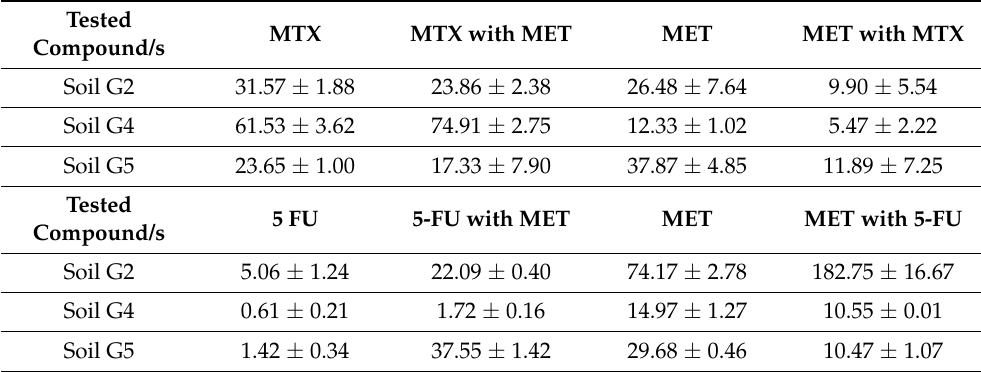
Table 3. The influence of the presence of metoprolol (MET) on the sorption coefficients ( K d * [L · kg − 1 ]) of MTX and 5-FU onto investigated